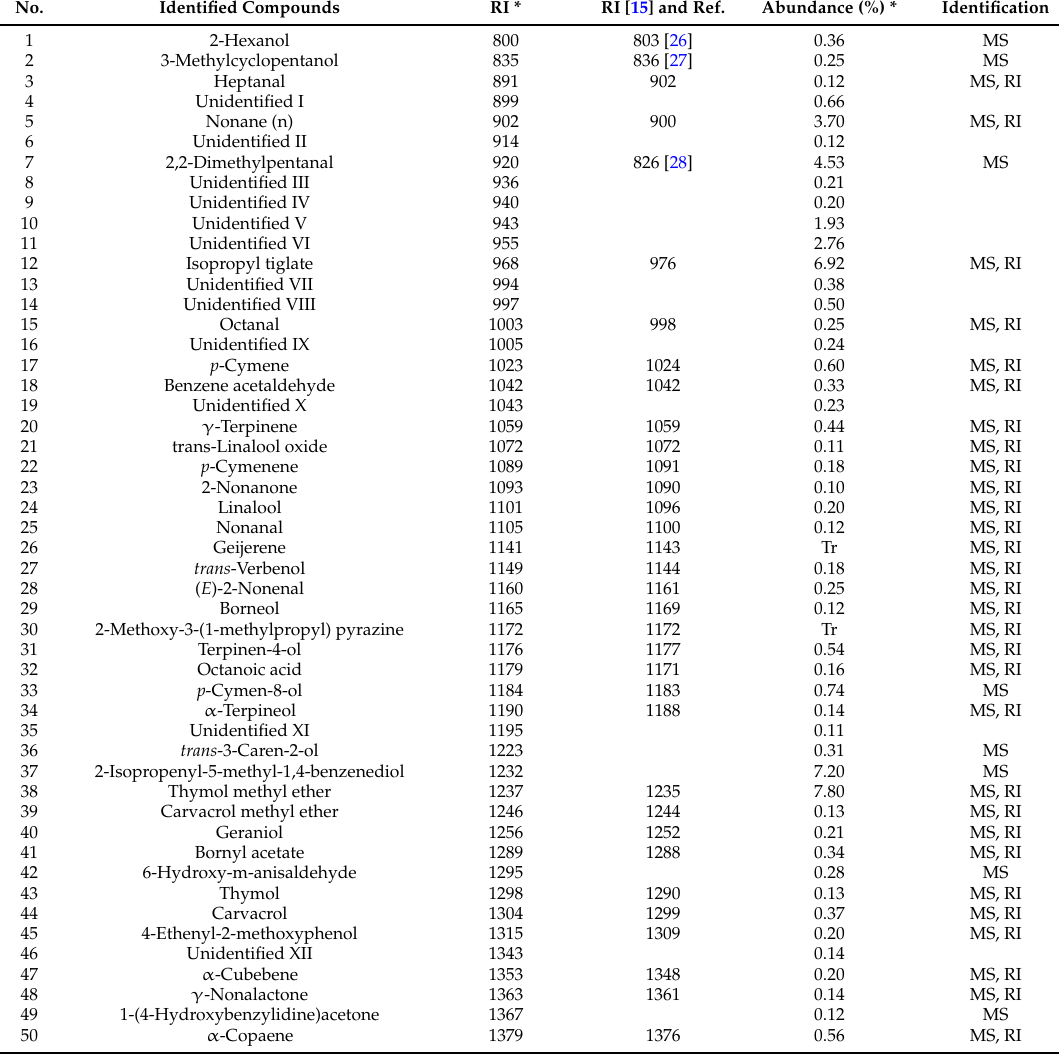
Table 1. Chemical composition of aerial part essential oils(Eos) from P. pruatjan .